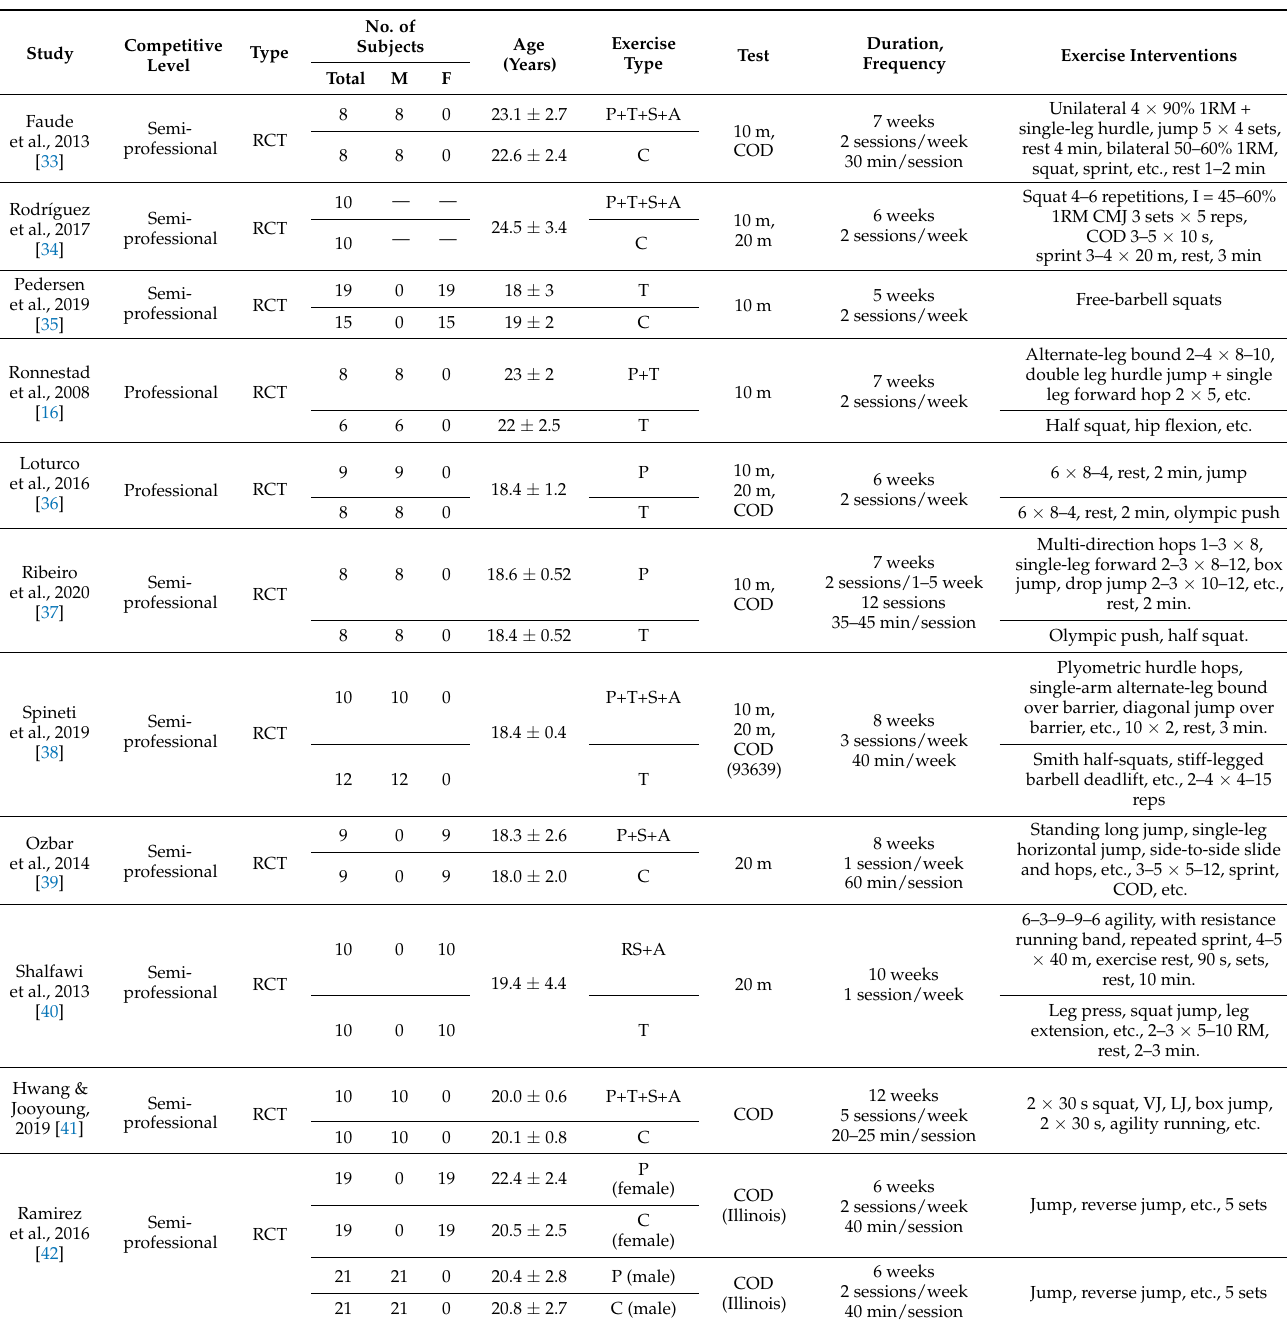
Table 2. Characteristics of study participants.